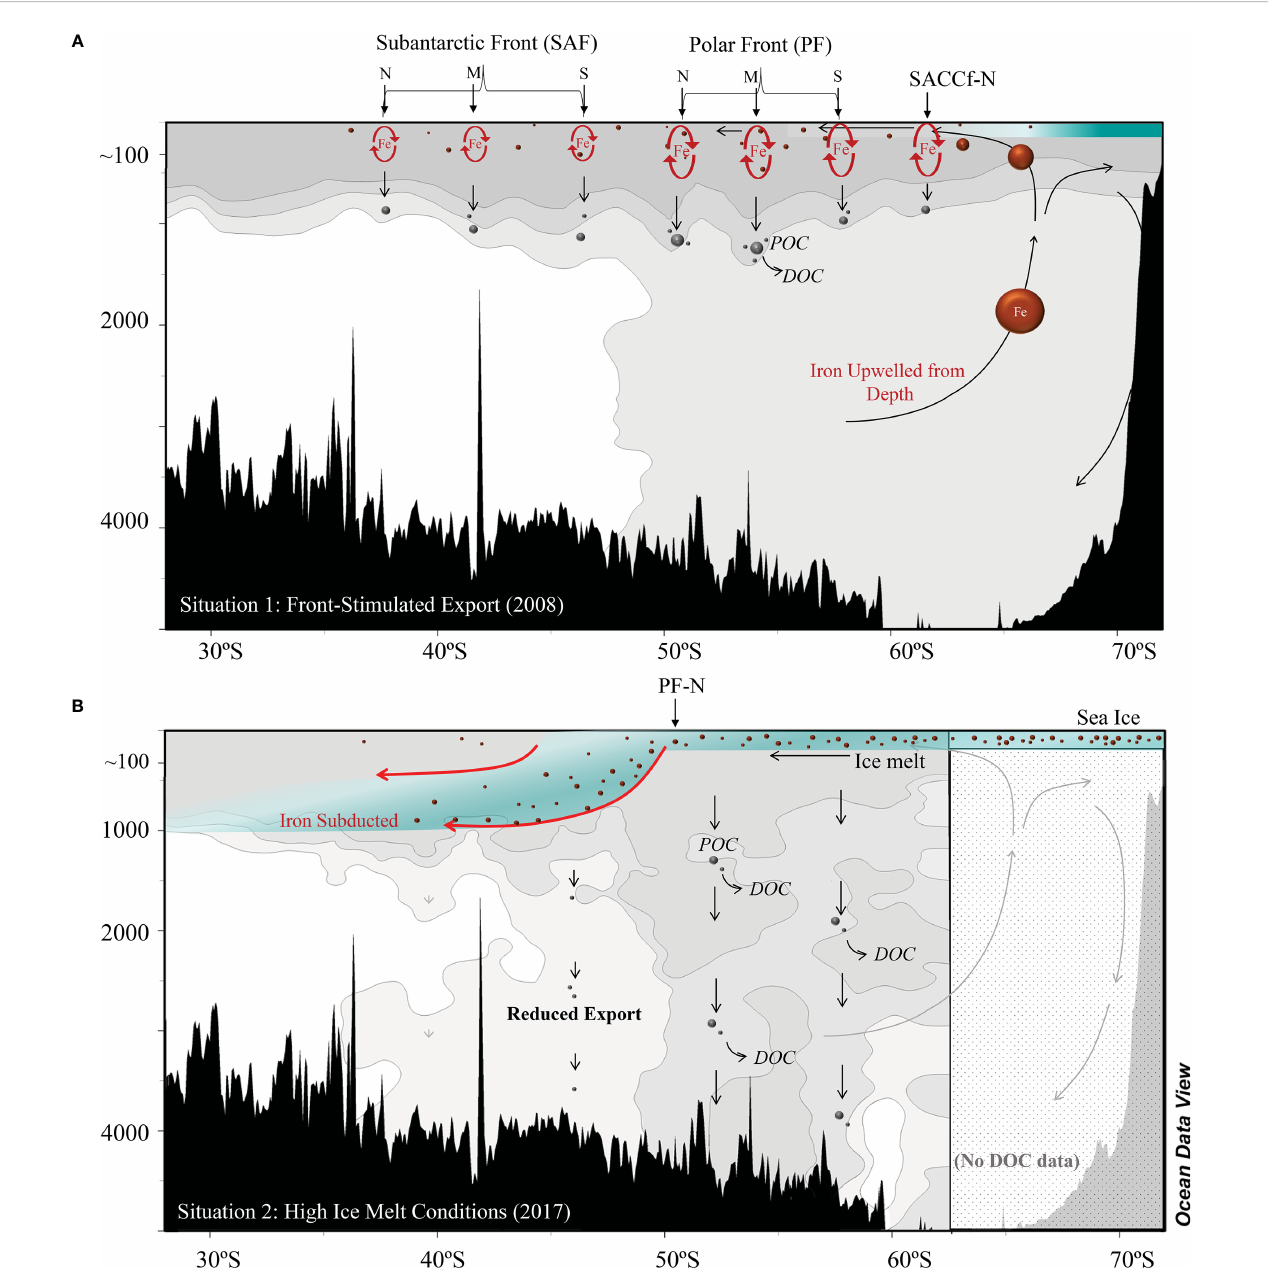
FIGURE 3 (A) Mechanism stimulating front-associated export overlayed on 2008 DOC distribution (grayscale; higher concentrations are deeper gray). Dissolved iron (depicted as red spheres) is upwelled from depth at high latitudes, renewing the upper ocean, and subsequently fl ows northward within the Ekman Layer. Vertical mixing at the fronts cycle iron to the surface ocean, enhancing production and subsequent particle export (gray spheres) to the upper bathypelagic. Exported particles release DOC upon descent, resulting in narrow features of enhanced DOC concentrations beneath the fronts. (B) Mechanism stimulating ice-associated export overlayed on 2017 DOC distribution (gray shaded area). As sea ice melts, its associated iron (depicted as red spheres) is transported northward, supplying the euphotic zone with elevated concentrations of bioavailable iron that stimulates production. As a result, widespread particle export ensues (gray spheres), releasing DOC to the water column upon descent to the deep bathypelagic. At the PF-N, meltwater subducts, sinking iron out of the euphotic zone and stunting equatorward production. Ice melt can also be imported laterally with the fl ow of the ACC. Upper-ocean depths are not to scale. Circulation derived from Carter et al., 2022 and Hansell and Carlson,